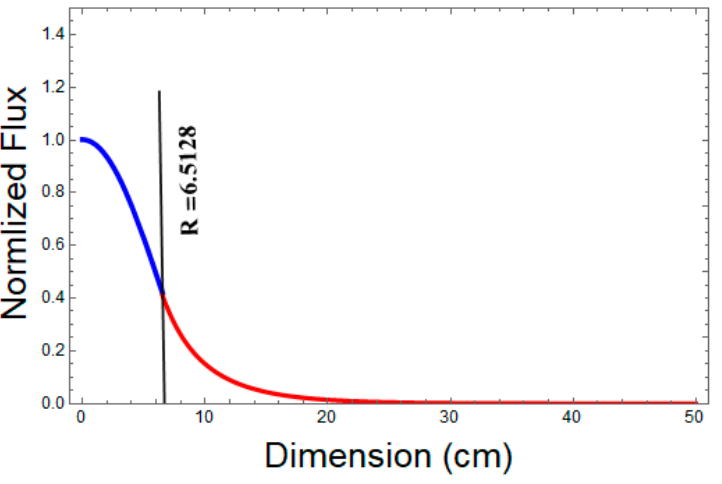
Figure 2. Flux distribution of one ‐ group reflected reactor. Blue, core flux; Red, reflector flux.